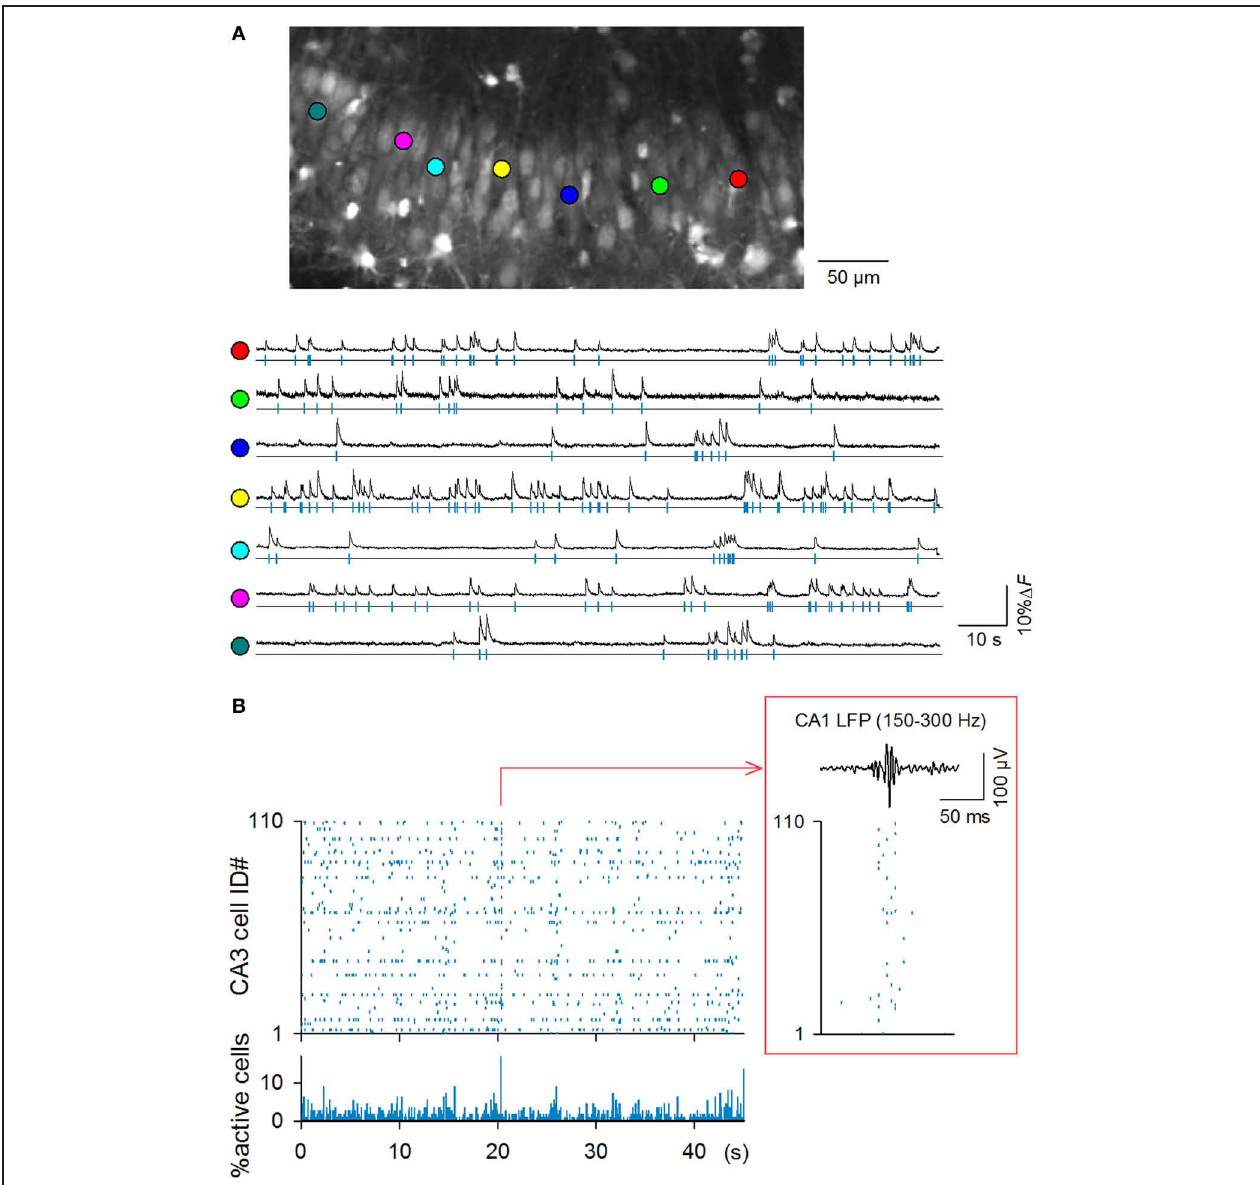
FIGURE 1 | High-speed fMCI of spontaneous CA3 network activity. (A) Top : representative confocal image of the CA3 stratum pyramidale in an OGB1-loaded hippocampal slice culture. Bottom : Time changes in the OGB1 fluorescence intensity in the somata of 7 randomly selected neurons indicated by the colored circles in the top photograph. (B) Representative